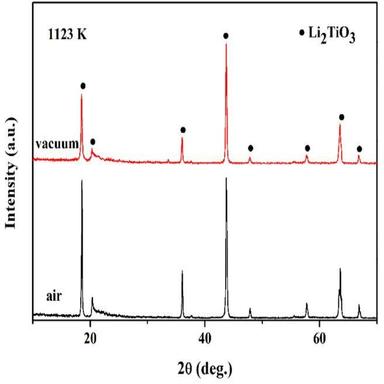
XRD patterns of the pebbles sintered at 1123 K in air and vacuum.